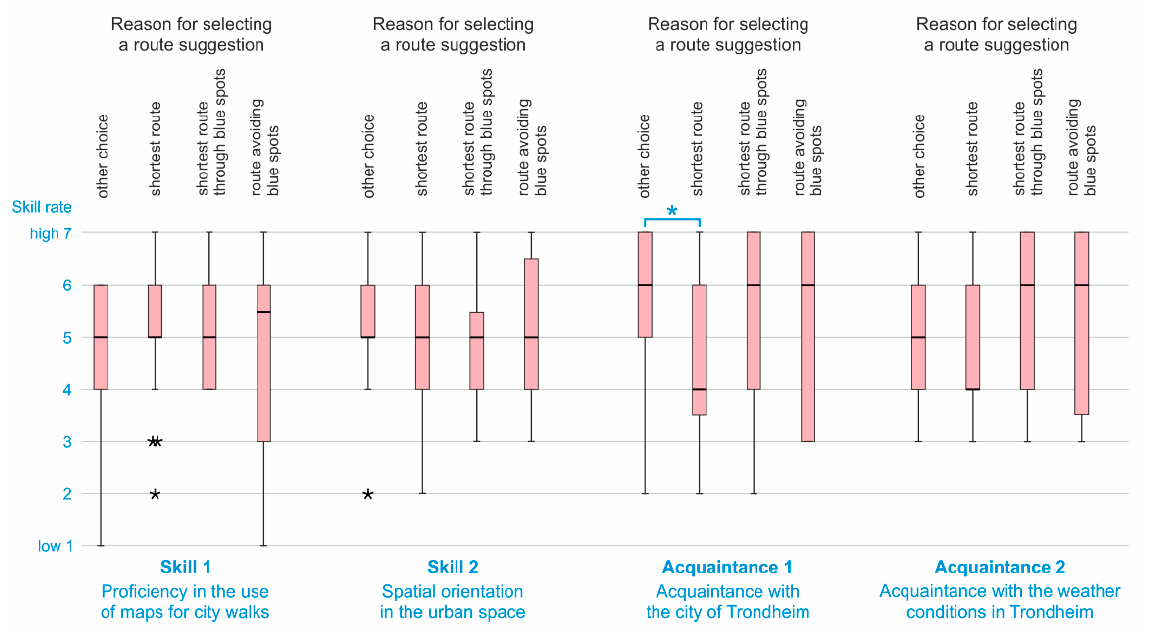
Figure 5. Users’ skills and acquaintances and reasons for selecting a specific route suggestion (black asterisks in the box plots show outliers in the datasets, whereas the blue asterisk above the box plot shows statistically significant differences).